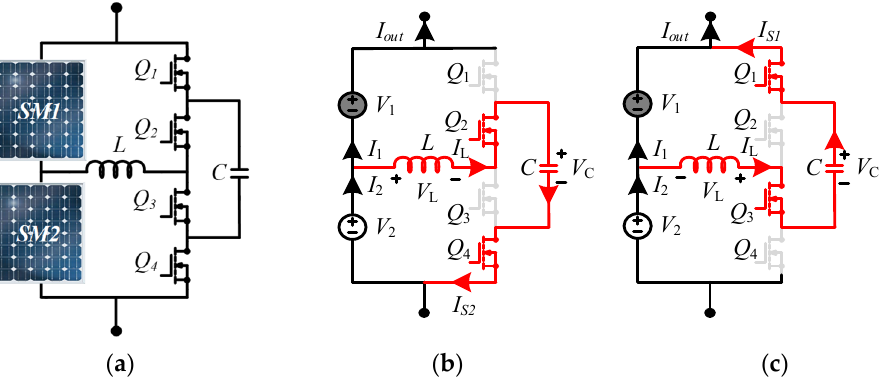
Figure 5. Proposed DPP topology ( a ) General circuit, ( b ) Energizing state/mode 1: power flow when SM2 is producing more than SM1 , ( c ) De-energizing state/mode 2: power flow when SM2 is producing more than SM1 . Here, L and C are switched-inductor and switched-capacitor used for the mismatch energy processing. I S 1 and I S 2 are the currents flowing through the switches Q 1 , Q 2 , Q 3 , and Q 4 .